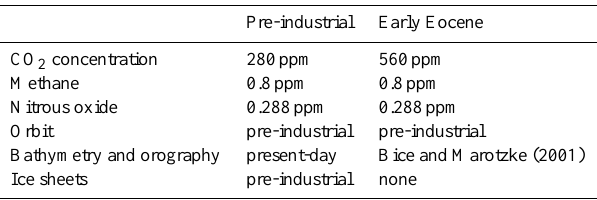
Table 2. Boundary conditions in the early Eocene climate simula- tions and in the pre-industrial climate